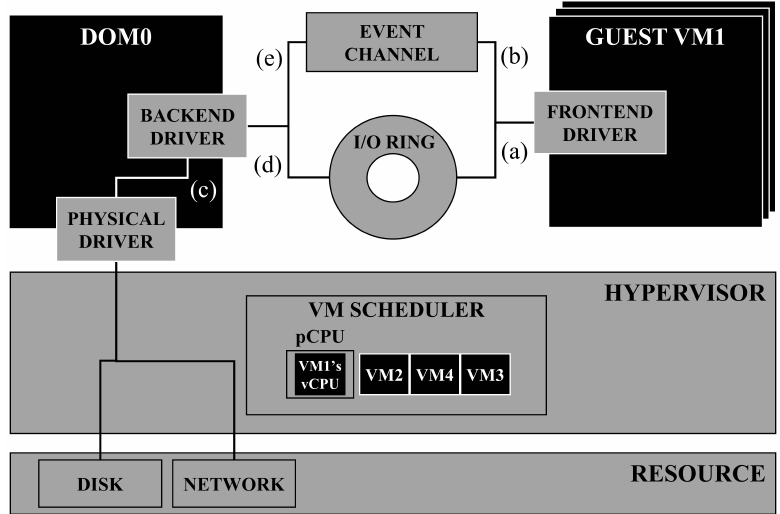
Figure 1. Xen’s I/O procedure. DOM, domain; pCPU, physical CPU; vCPU, virtual